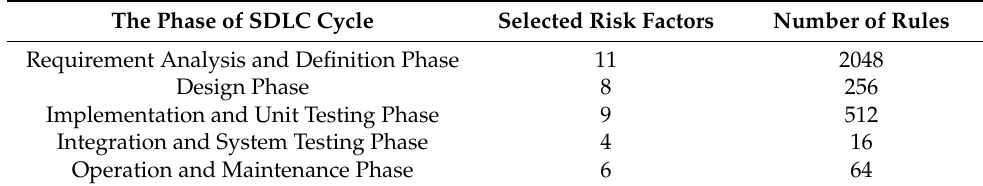
Table 8. Distribution of the number of inferred rules.